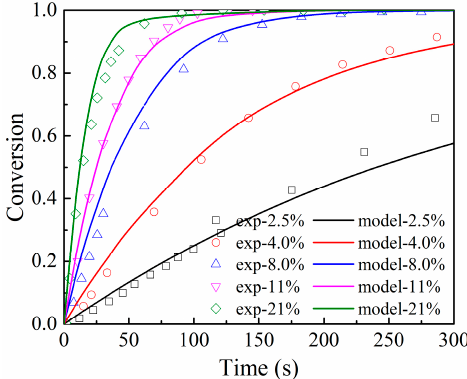
Figure 4. Effects of O 2 volume percentage (vol%) on conversion at 900 ◦ C. ([O 2 ] = 2.5~21 vol%, N 2 as equilibrium gas. Dots: experimental data [42]; lines: model results.)